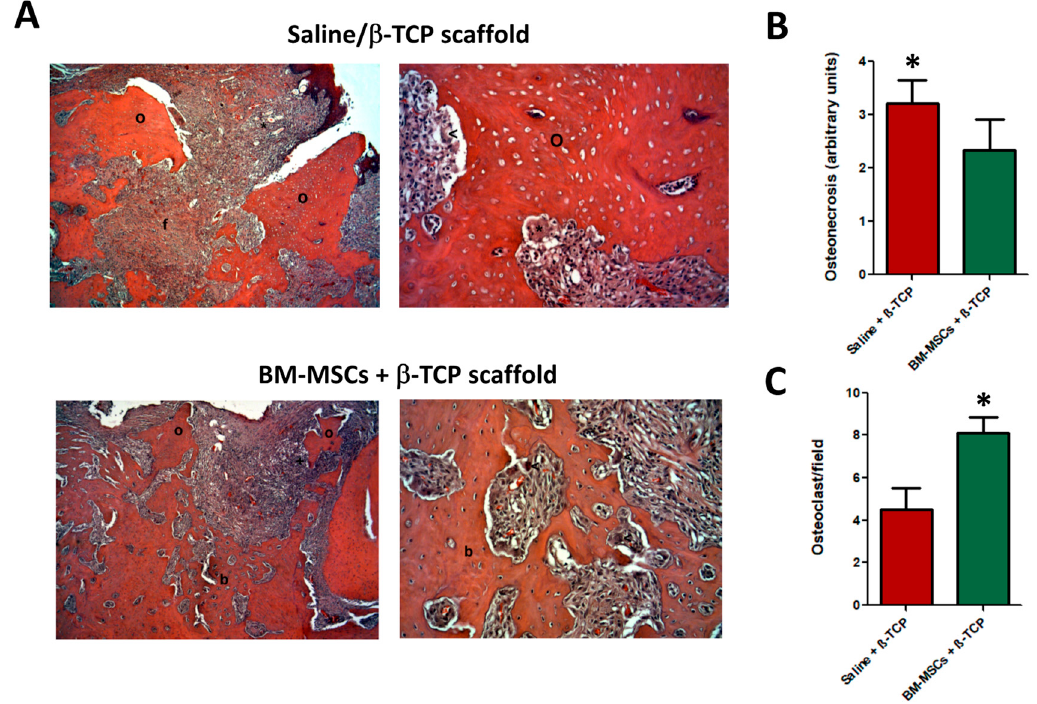
Figure 4. Representative images of HE staining of maxillary bone after induction of osteonecrosis in control animals transplanted only with saline + β -TCP scaffold, ( A , top images) and those treated with BM-MSCs + β -TCP scaffold ( A , bottom images) 4 weeks after treatment. Left images magnification: × 100; Right images magnification: × 400; ( B ) control animals displayed a higher degree of osteonecrosis than BM-MSC-treated counterparts (* p < 0.05) whereas osteoclast number per high-power field at 400 × was significantly augmented in ( C ) the BM-MSC-treated group (* p < 0.05). Symbols: o: osteonecrotic areas; f: fibrotic areas; b: bone neoformation.